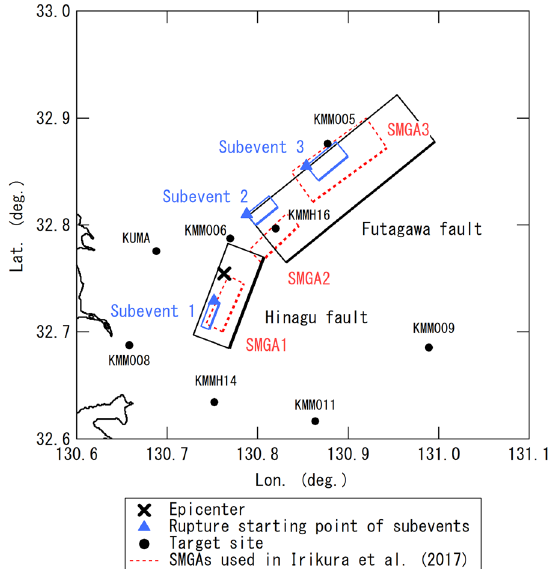
Fig. 11 Location of reference case subevents for the earthquake of 2016/04/16 01:25 ( M w 7.1). Blue rectangles indicate the projections of subevents used for the simulation. Projections of the Hinagu and Futagawa faults were estimated by Geospatial Information Authority of Japan, which are shown only for reference and not considered in the simulation. Blue triangles indicate the rupture starting points of the subevents. Red dashed rectangles indicate SMGAs used in Irikura et al. (2017) shown only for reference. Black dots indicate the target sites of the